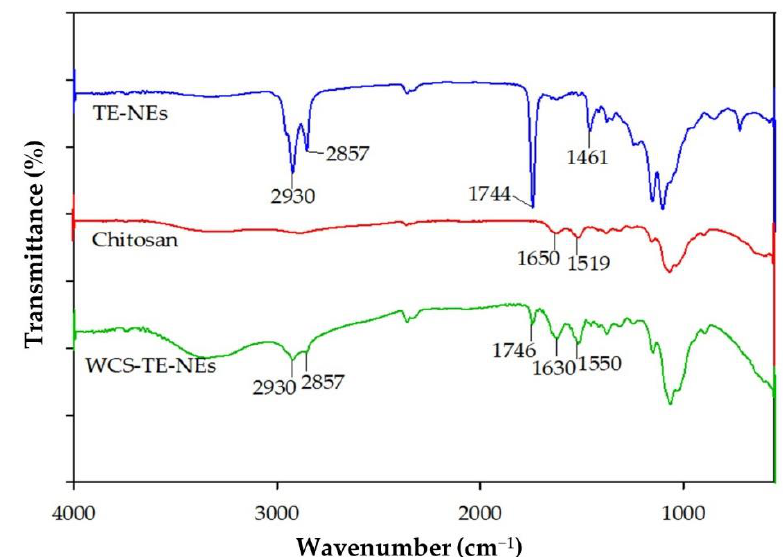
Figure 6. FT-IR spectra of TE-NEs, water-soluble chitosan, and WCS-TE-NEs.